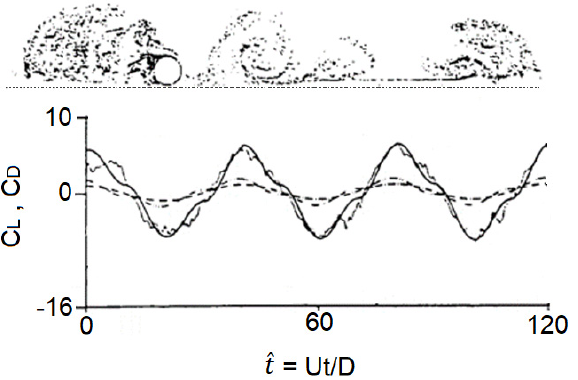
Fluids 2021 , 6 , x FOR PEER REVIEW 18 of 20 Figure 19. The flow pattern at t = 120, and the force coefficients for G/D = 0.2, Kc = 40 and Re = 25,000. As has been discussed already, the present study model cannot reproduce the effects, and although the results are surprisingly close to experimental results for the larger gap ratios, for G/D less than 0.2, they become increasingly unrealistic, as shown in Figure 20. The effect of the wall proximity on the lift coefficient of a circular cylinder is shown in